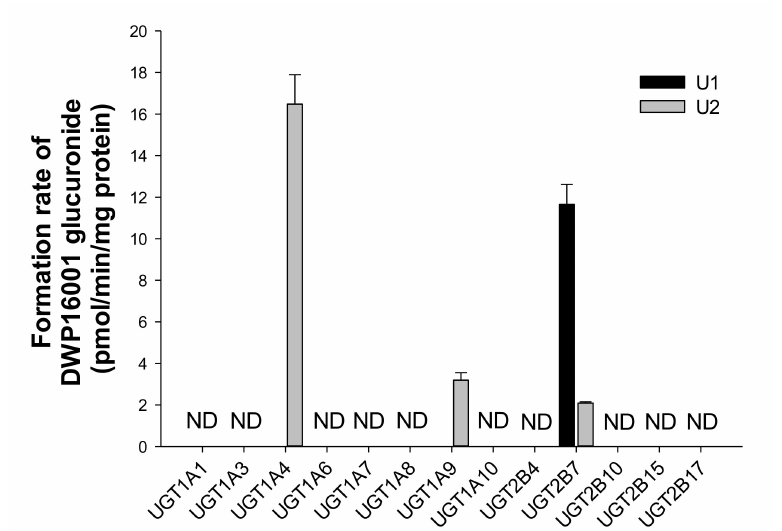
Figure 7. Formation rates of U1 and U2 from DWP16001 after incubation of 25 µ M DWP16001 with human cDNA-expressed UGT1A1, UGT1A3, UGT1A5, UGT1A6, UGT1A7, UGT1A8, UGT1A9, UGT1A10, UGT2B4, UGT2B7, UGT2B10, UGT2B15, and UGT2B17 enzymes in the presence of UDPGA. Quantification was performed using the calibration curve of U3 because no authentic standards of U1 and U2 were available. ND: not detected (lower limit of quantification: 1.67 pmol / min / mg